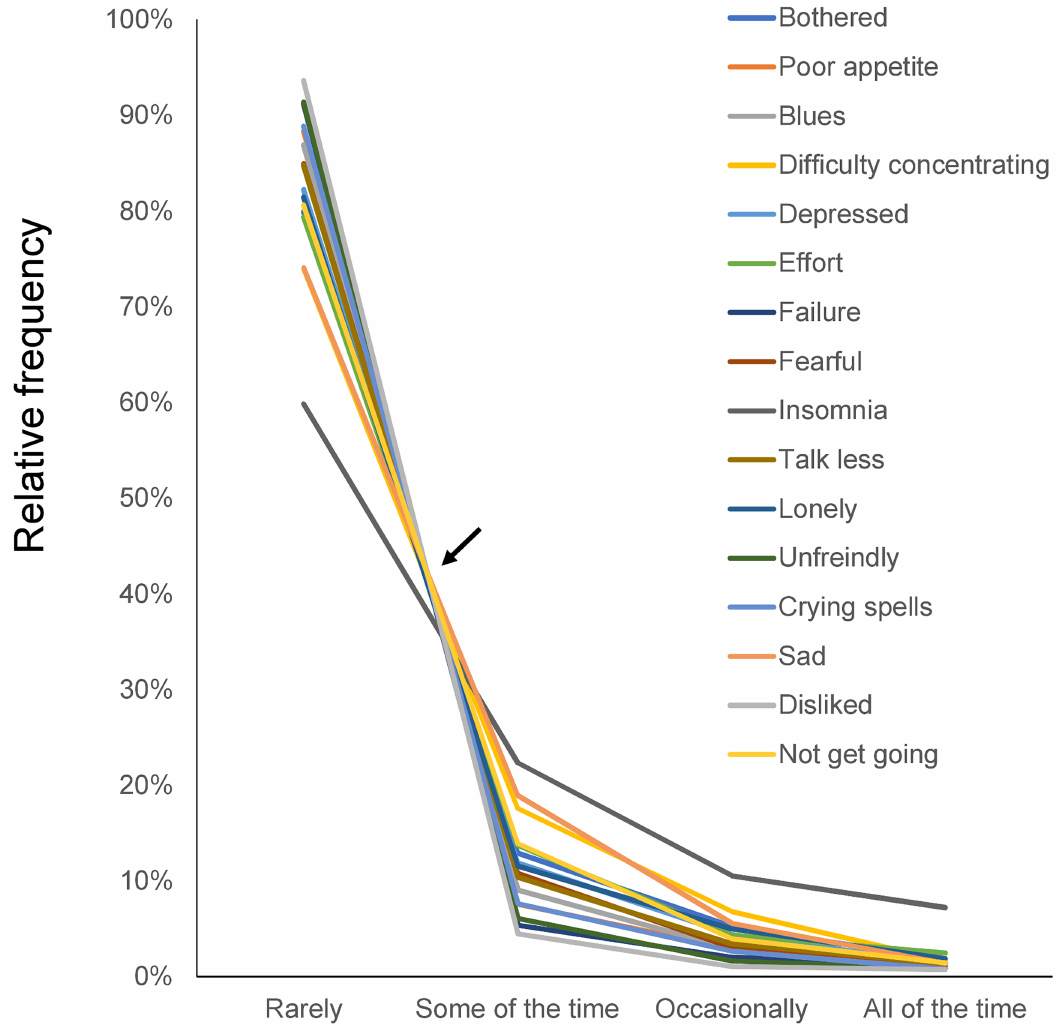
Fig 3. Item responses of the 16 depressive symptom items in the TILDA. Responses to the 16 items exhibited a common mathematical pattern. Lines for the 16 items intersected at a single point (arrow) between “rarely” and “some of the time,” whereas the lines from “some of the time” to “all of the time” decrease regularly. The line for “insomnia” intersected distal to the intersection